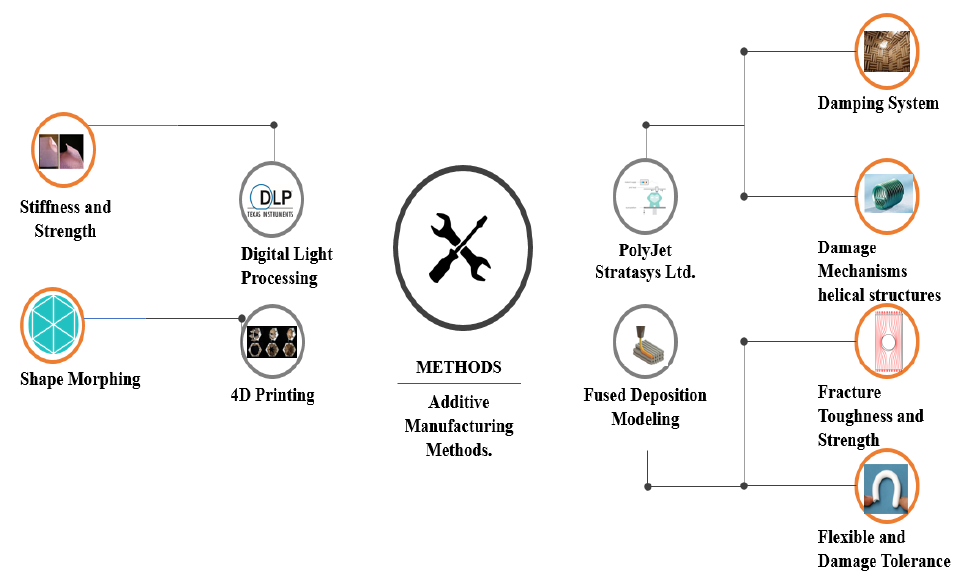
Figure 5. Additive manufacturing to reform optimize biomimetic [28].